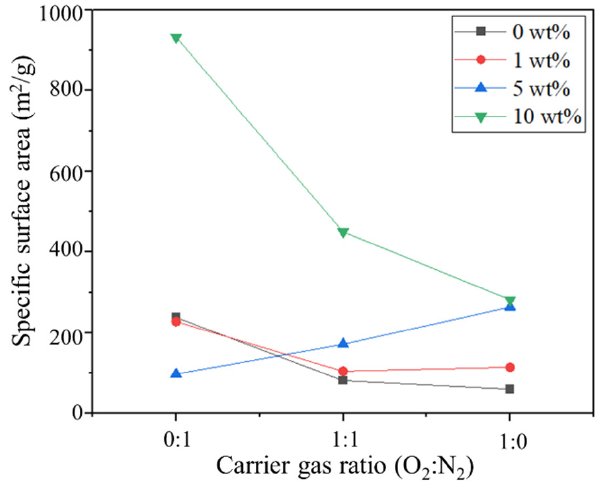
Figure 6. Specific surface area of ZnO and ZnO-Ag at different Ag contents and carrier gas (O 2 :N 2 ) ratios.